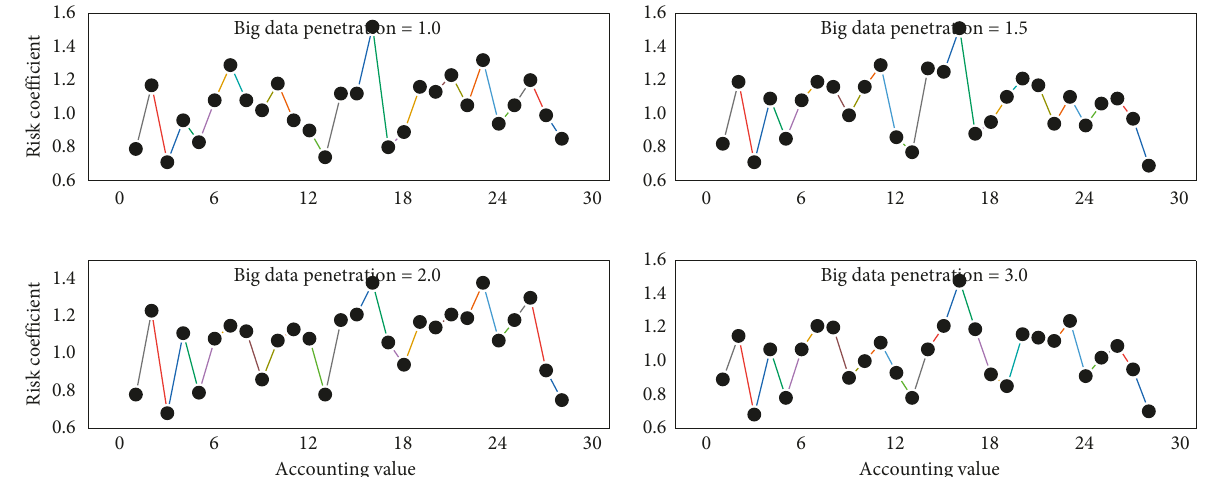
Figure 1: The curve distribution of accounting risk coefficient under different flows’ big data’s era.